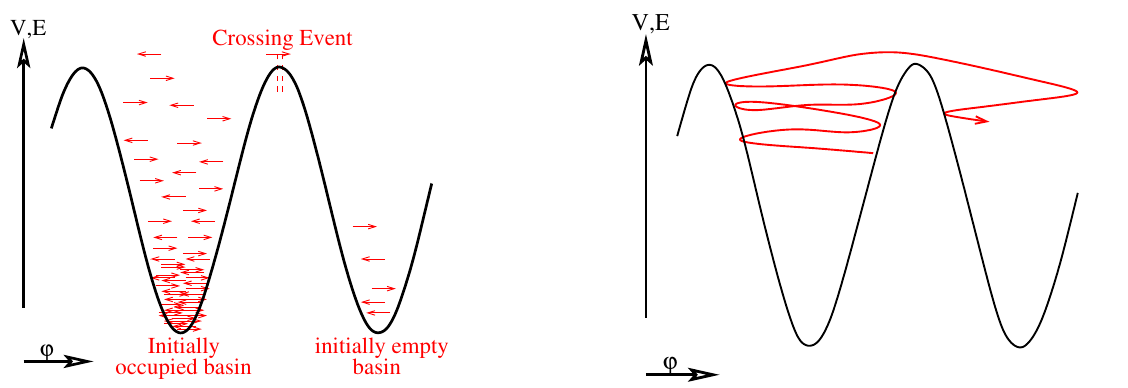
Figure 2 . Cartoon of thermal activation in the pendulum toy model. Left: when one basin starts filled and one starts empty, the rate to move across is the flux across the top, which is the probability to be near the top times the rate of crossing. Right: for typical damping, an evolution bounces in one basin, gains enough energy to cross, and then bounces in the next basin.